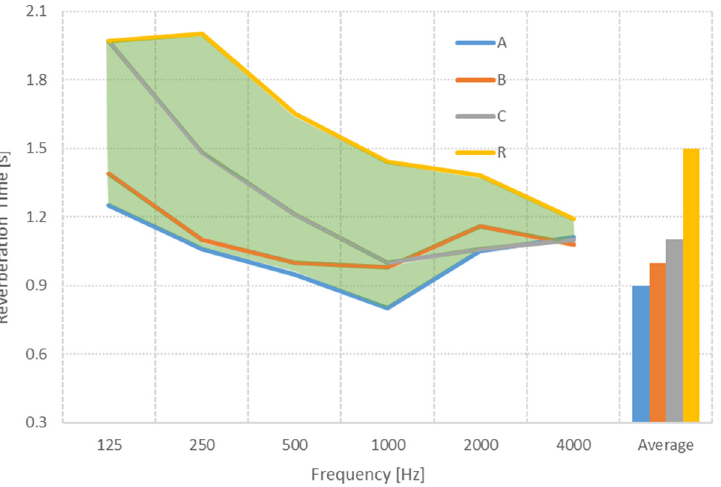
Figure 7. Average reverberation time (RT) in the auditorium for different octave bands obtained for the variable acoustic perforated systems analyzed (configurations R, A, B and C).